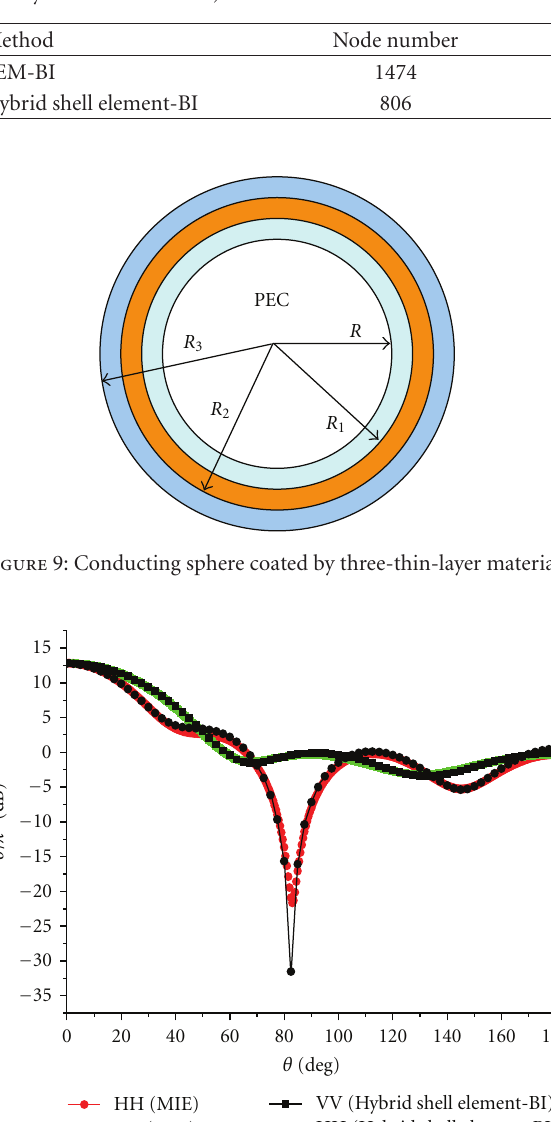
Table 2: The comparison of the FEM-BI and the hybrid shell element-BI. Bistatic RCS of the conducting cube coated by thin material (mesh density with 10 elements / λ ).